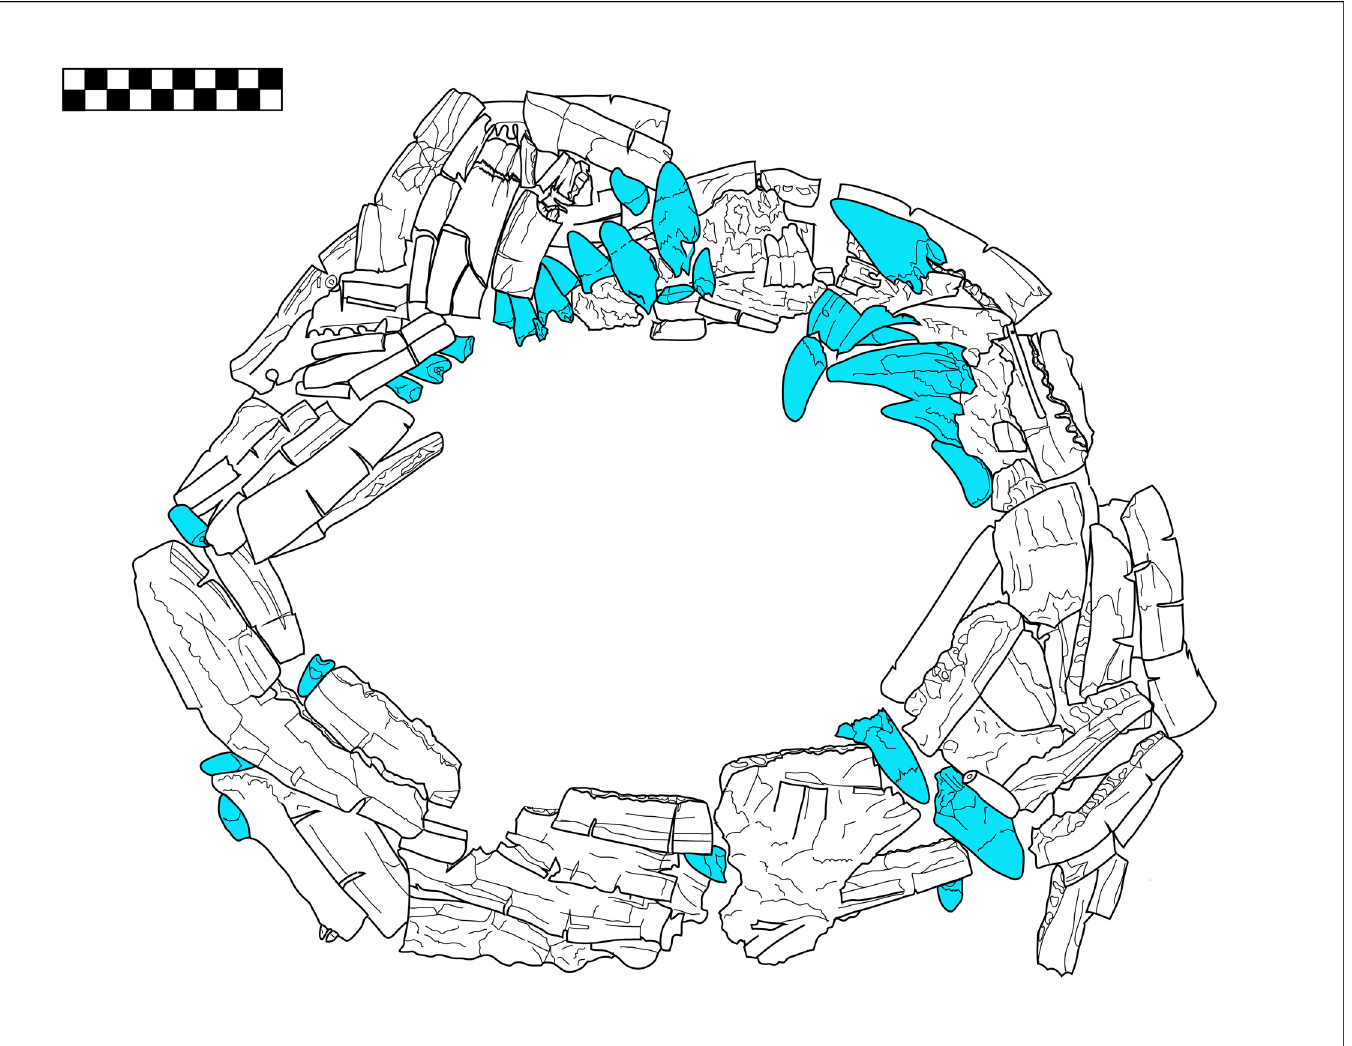
Fig 2. Plan view drawing of deer mandibles and crocodile teeth collar from Burial VIII-36, Plaza A of group 9N-8. Crocodile teeth are in blue. Drawing by N. Sugiyama.